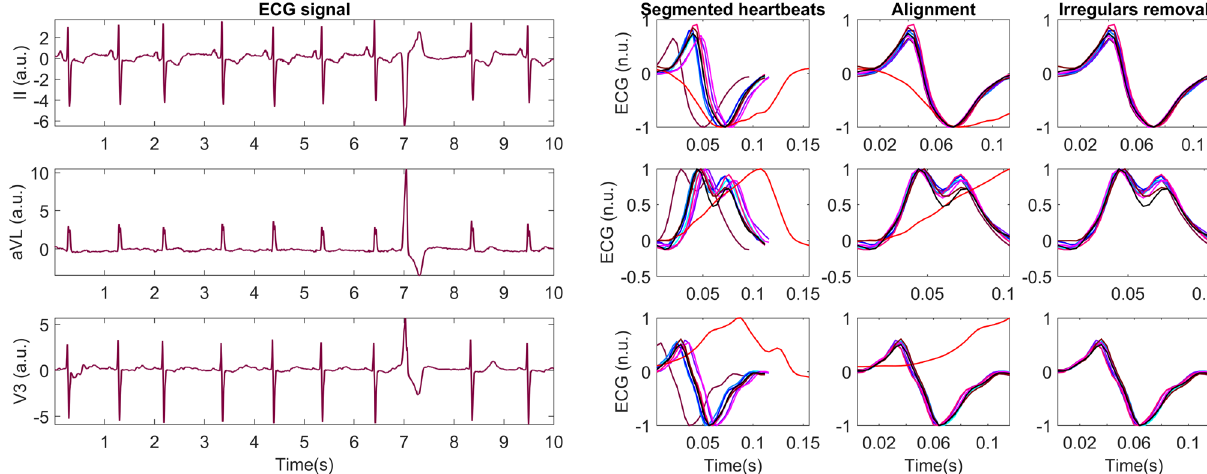
Figure 2. Example QRS segmentation for multi-lead signal with irregular heartbeats, showing the segmentation steps for leads II, aVL and V3. From left to right, the columns show the ECG signal, the segmented heartbeats (step 4 of Algorithm 2), the aligned heartbeats (step 5), and the final segmented heartbeats after removing irregular